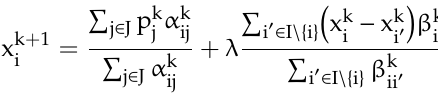
Figure 3. Objects on the floor. The offset space is determined by door height experientially.